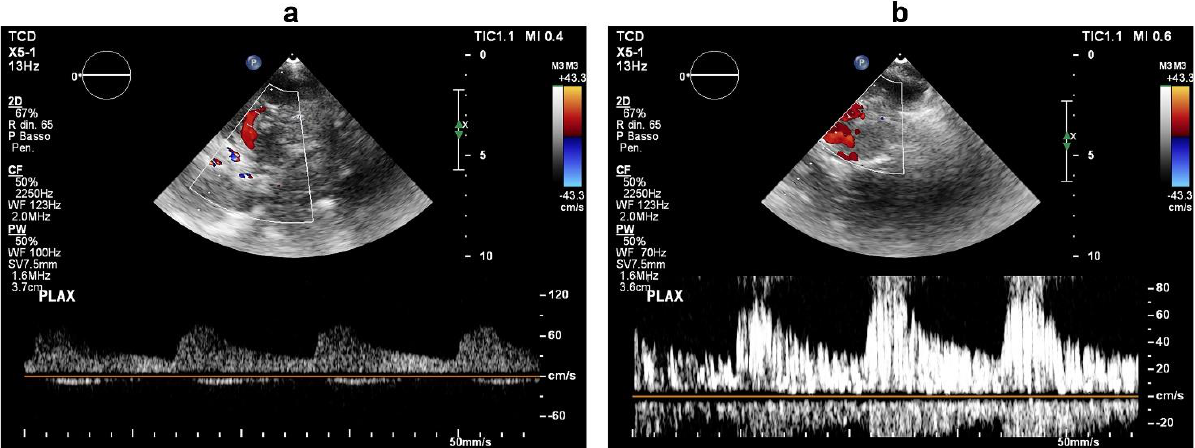
Figure 2. Transcranial Doppler ultrasound during intravenous infusion of agitated saline at baseline ( a ) and during a Valsalva manoeuvre ( b ). In ( b ), the middle cerebral artery Doppler signal exhibits a “shower effect” (>25 microembolic signals), which indicates a high-grade right-to-left shunt.